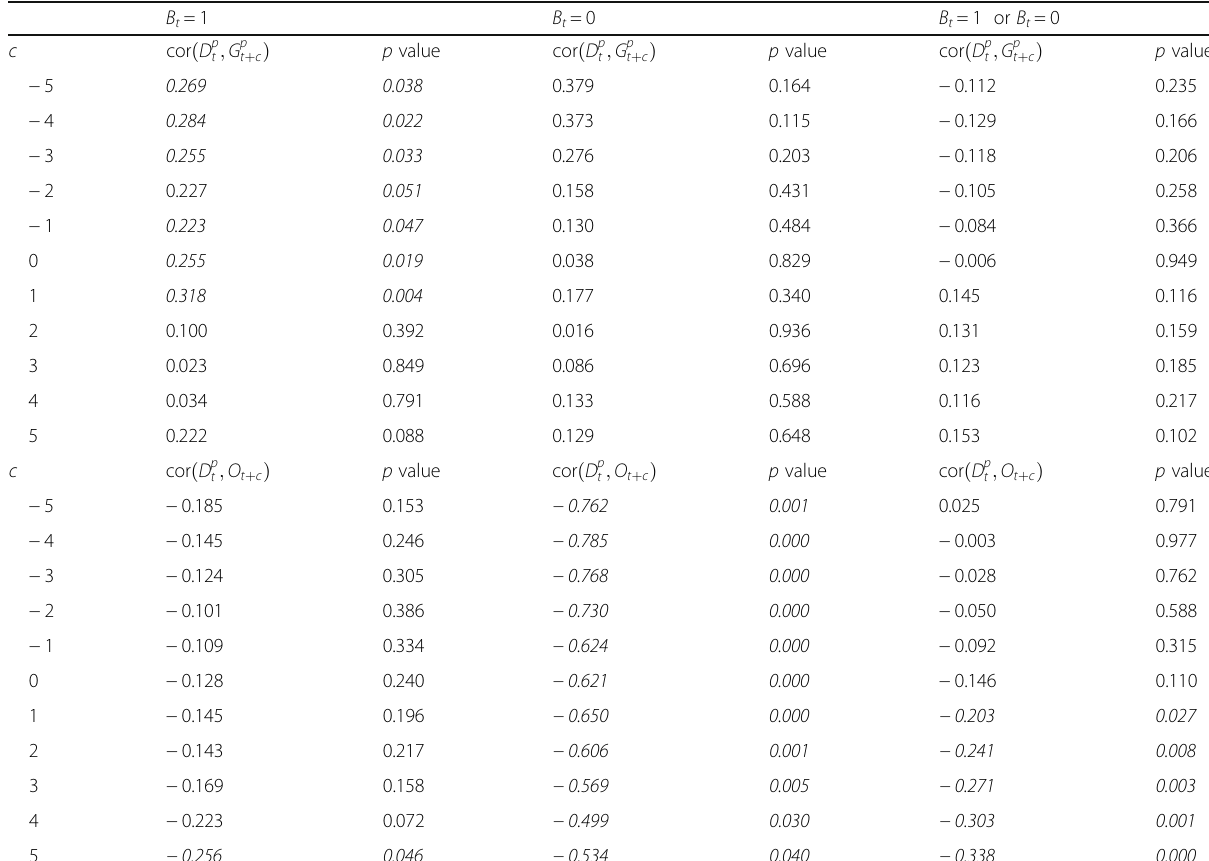
Table 1 Top: Pearson correlation coefficients between debt-to-GDP ratio and GDP growth rate for boom phases, recession phases and all data. Bottom: Pearson correlation coefficients between debt-to-GDP ratio and long-term interest rates for boom phases, recession phases and all data. Italics: significant results with 5%